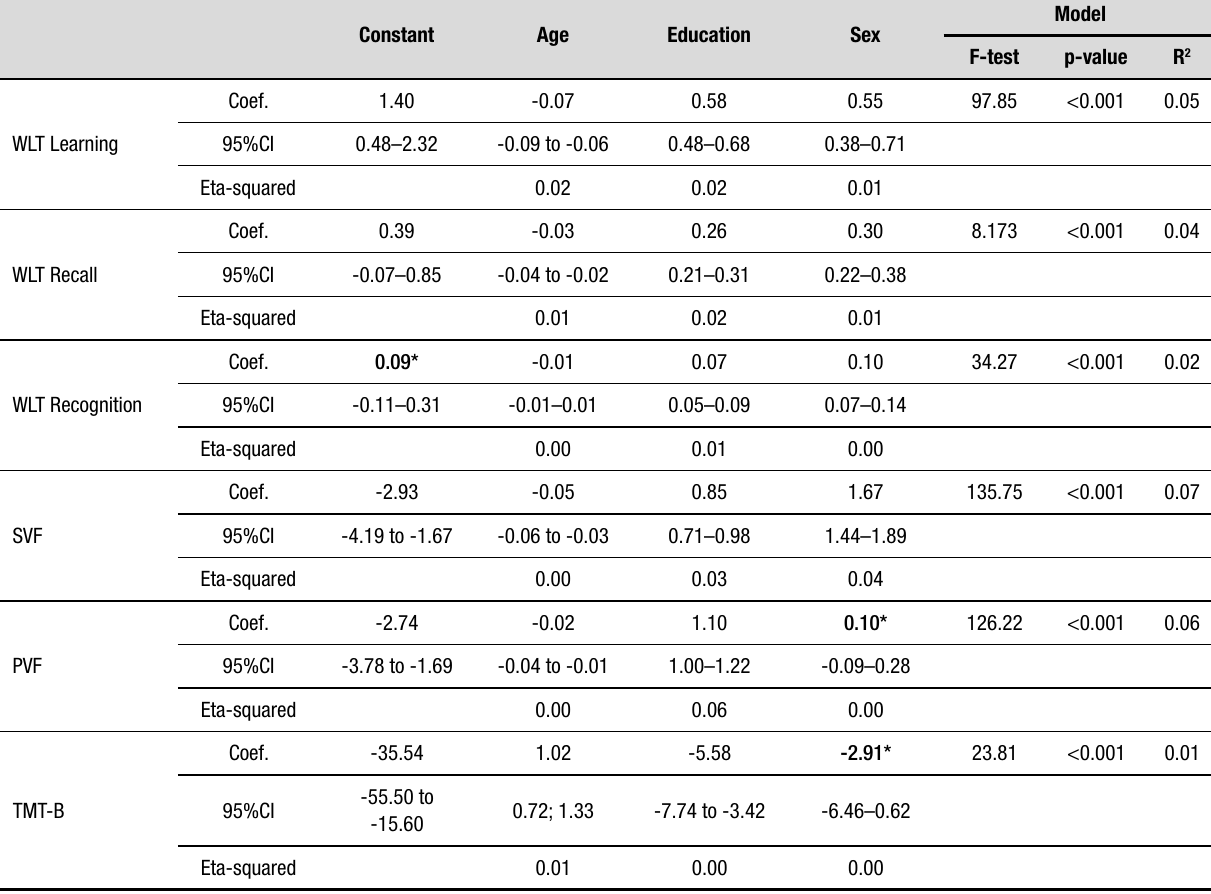
Table 4. Linear regression of sociodemographic predictors of retest effect